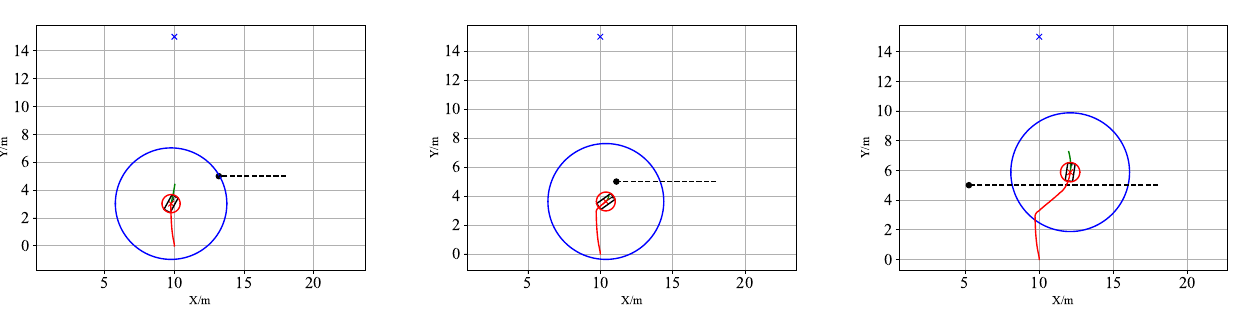
Figure 19. Parameters of the PSO-CCDWA algorithm for overtaking situation. (3) Crossing situation